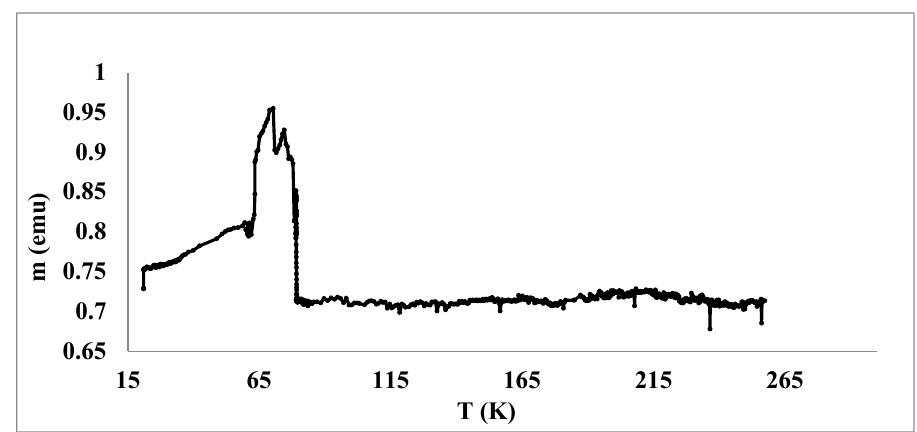
Figure 10. Magnetic moment as a function of the temperature of Sample I.